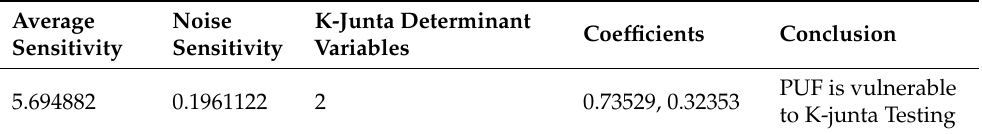
Table 4. PUFmeter results on RO PUF vulnerability against ML attacks.